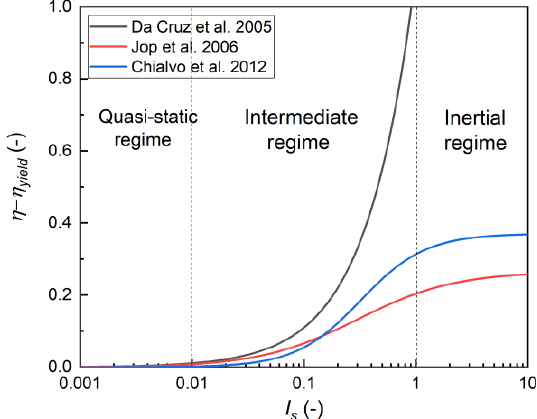
Figure 5. η(I s ) relationship at various flow regimes [50,54,55]. Figure 5. η (I s ) relationship at various flow regimes [50,54,55].